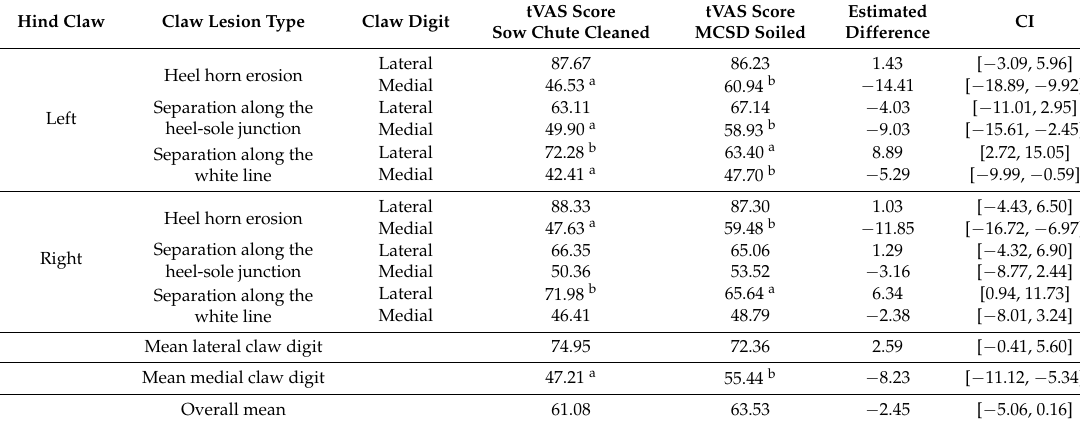
tVAS = tagged visual analogue scale for claw lesion scoring in sows as described in [9,10,31] and adapted and modified from the scorings methods of Wageningen University and FeetFirst (Zinpro Corporation, Eden Prairie, MN, USA). To score the claw area for claw lesions, a vertical bar was drawn on the line and the distance from 0 mm determined (0 mm is most healthy and 160 mm is most severe). MCSD = Mobile Claw Scoring Device. CI = confidence interval. FeetFirst © chute, “sow chute”, Zinpro Corporation. Level of significance = 0.05 using a linear mixed model. a,b LSmean values within a row lacking common superscript letters differ significantly; p < 0.05. The average claw lesion scores for the lateral claw digit and for the overall mean claw lesion score did not differ between the sow chute and the MCSD (Table 2). The average claw lesion score for the medial claw digit differed. This estimated difference was 8.23 mm on a 160 mm tVAS scoring scale, showing higher tVAS values for the